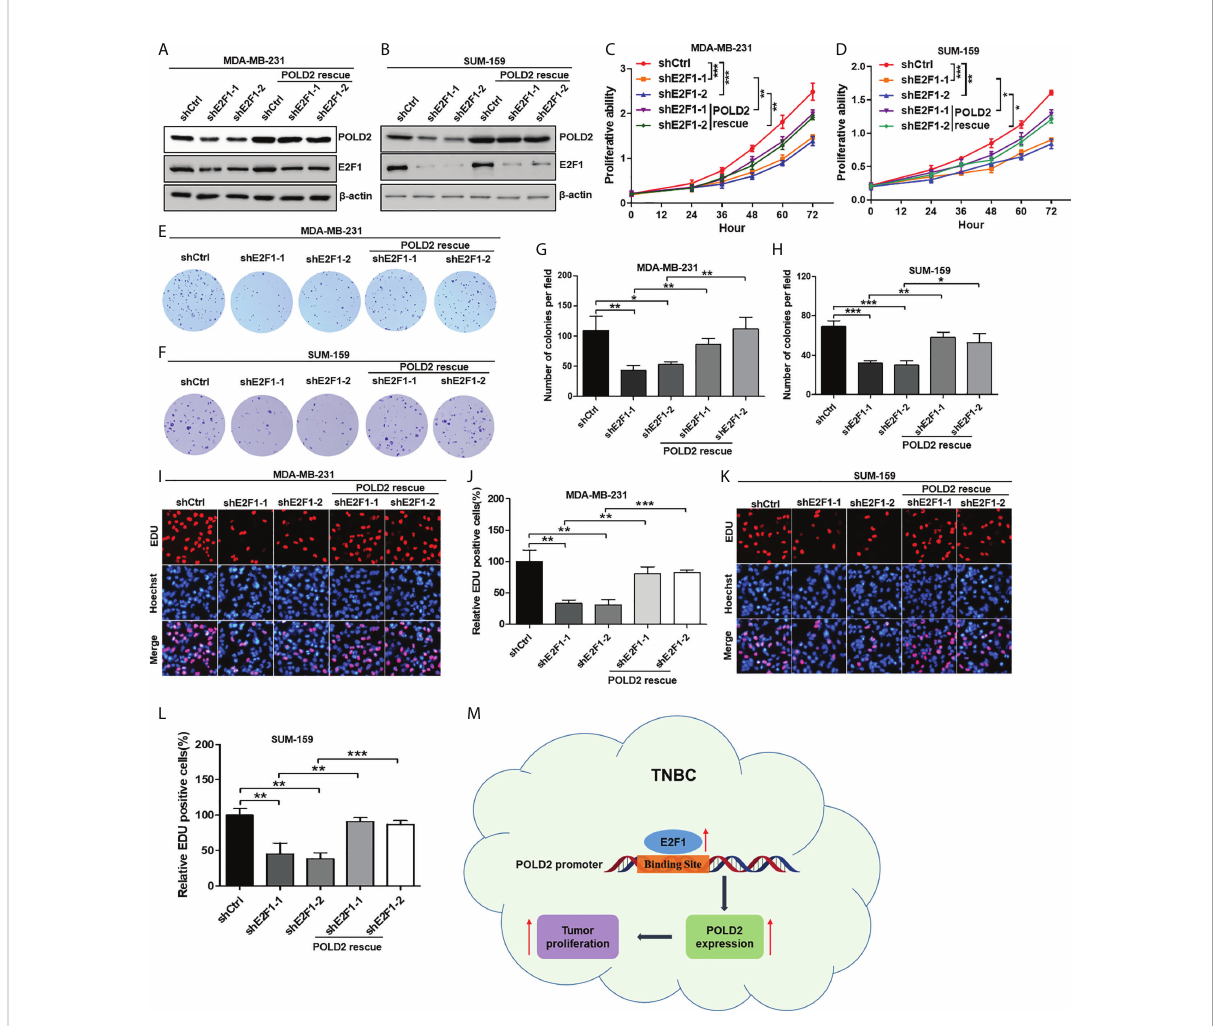
FIGURE 4 POLD2 antagonizes the effect of E2F1 knockdown in regulating TNBC proliferation. (A, B) The protein expression of E2F1 and POLD2 in shCtrl/ 231, shE2F1/231, shCtrl/159, and shE2F1/159 cells in the presence or absence of overexpressed POLD2. (C, D) The effect of E2F1 on MDA-MB- 231 and SUM-159 cells viability in the presence or absence of overexpressed POLD2 was determined by CCK-8 assay. *** P < 0.001, ** P < 0.01, * P < 0.05. (E – H) The effect of E2F1 on MDA-MB-231 and SUM-159 cells ’ colony formation abilities in the presence or absence of overexpressed POLD2 was determined by colony formation assay. *** P < 0.001, ** P <0.01, * P < 0.05. (I – L) The effect of E2F1 on MDA-MB-231 and SUM-159 cells ’ proliferation abilities in the presence or absence of overexpressed POLD2 was determined by EDU incorporation assay. *** P < 0.001, ** P <0.01, * P < 0.05. (M) A working model of the E2F1-POLD2 signaling pathway in TNBC proliferation. Data represent the mean ± SD of three independent